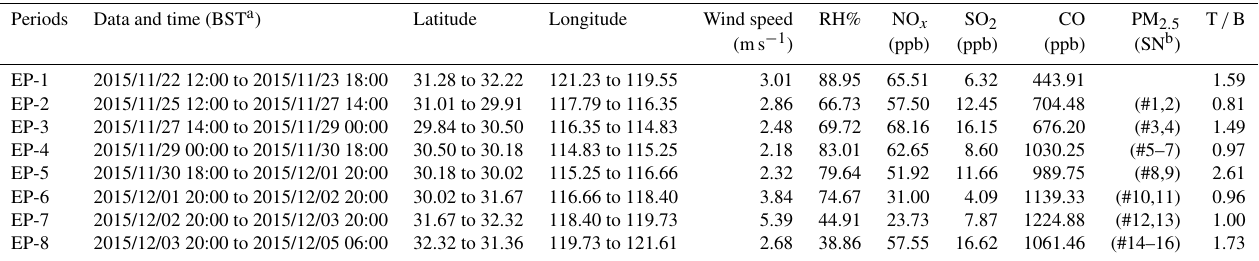
Table 2. The pollutant levels and meteorological parameters in eight different episodes. Dates and times are given in YYYY/MM/DD and